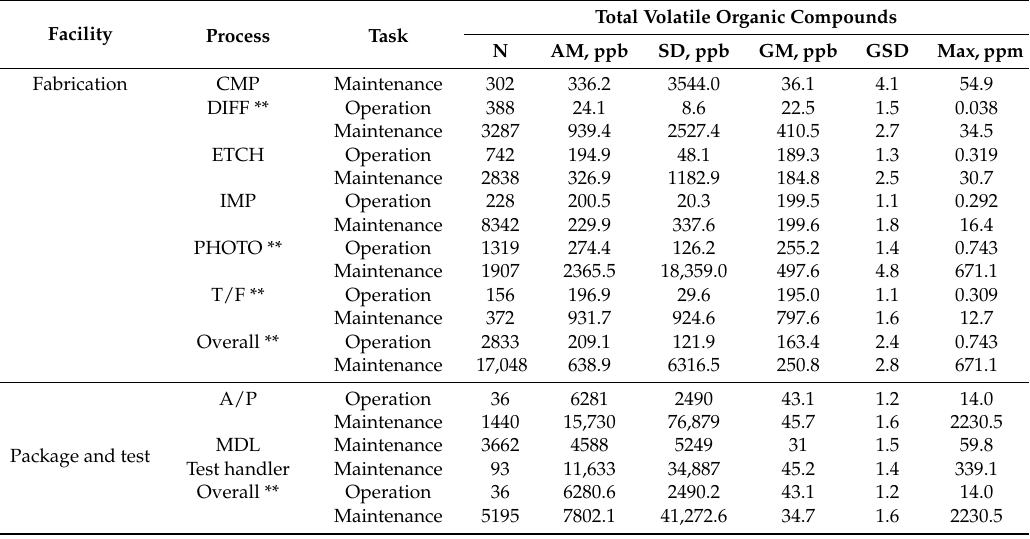
Table 5. Total volatile organic compound concentrations by process in semiconductor fabrication and package facilities.